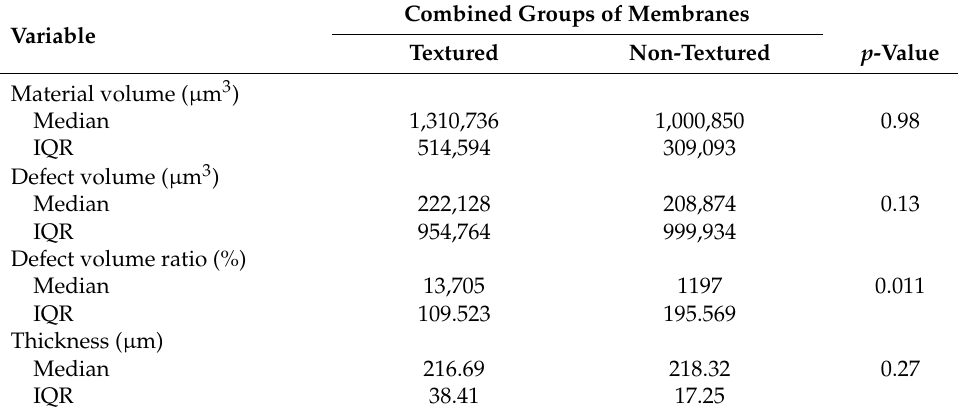
Table 5. Descriptive statistics for preplanned surface-type comparison